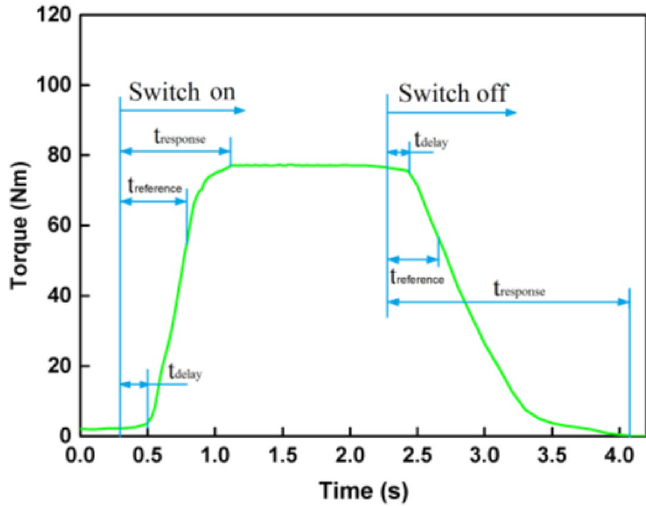
Figure 4. The typical definition of time parameters for the MR